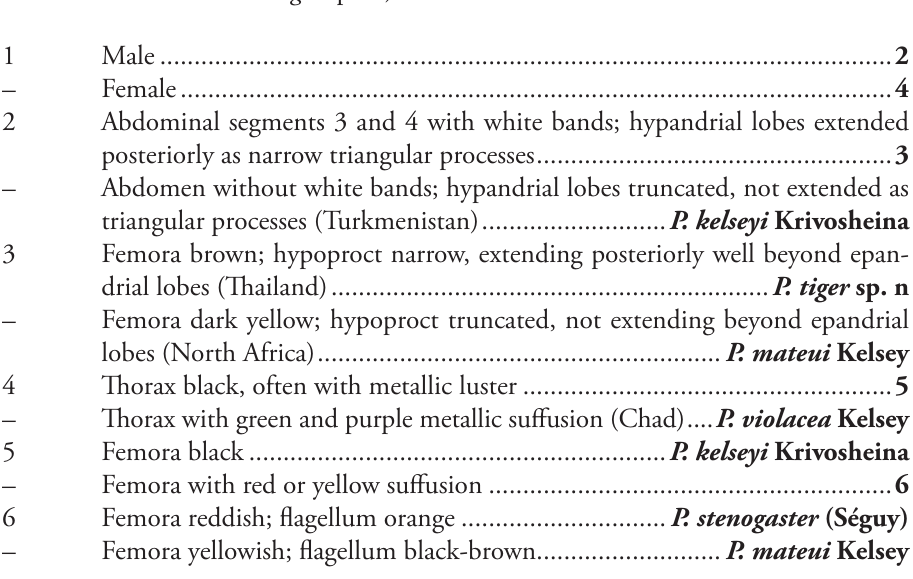
Type material. Holotype. male, THAILAND: Loei Phu Ruea National Park, Nern Wibaak ditch, 17°29.907'N, 101°20.483'E, 1196m, Malaise trap 26.ii-2.iii.2007, Pa- tikhom Tumtip leg. T1714 (QSBG). Diagnosis. Male abdomen with white bands on segments 3–4; antenna yellow- brown; thorax glossy black with metallic iridescence; femora brown; hypandrial lobes with triangular processes extending posteriorly to apex on epandrial lobes; hypoproct narrow, extending beyond epandrial lobes. eyes almost contiguous at narrowest point; face brown-black, parafacia narrow, gla- brous; mouthparts brown; antenna yellow-brown, overlain with greyish